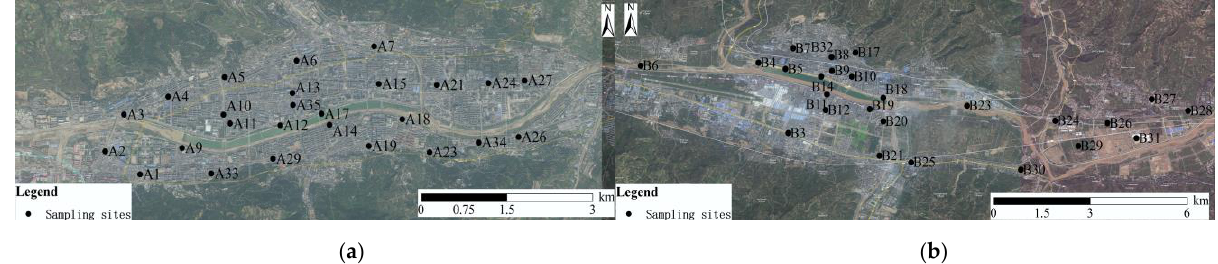
Figure 1. Dust sampling sites at sampling stations in Tianshui City. ( a ) Qinzhou District; ( b ) Maiji District.